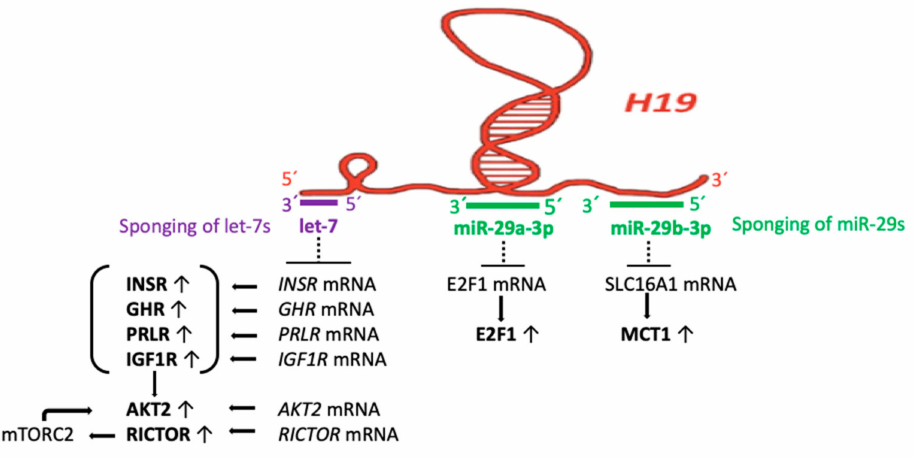
Figure 3. Long non-coding RNA H19 augments β cell proliferation. H19 functions as a sponge of let-7 miRs and miR-29 family members, resulting in the enhanced expression of growth hormone receptors, AKT2, and the mTORC2 component RICTOR. Growth hormone receptors and mTORC2 activate AKT2 and its downstream target mTORC1. H19-mediated sequestration of miR-29a-3p enhances the expression of E2F1, a known transcription factor promoting H19 expression. H19-mediated- sponging of miR-29b-3p enhances the expression of monocarboxylic acid transporter 1 (MCT1 encoded on SLC16A1 ), a disallowed gene of mature β cells. Abbreviations: INSR = insulin receptor; GHR = growth hormone receptor; PRLR = prolactin receptor; IGF1R = insulin-like growth factor 1 receptor; AKT2 = AKT serine/threonine kinase 2; RICTOR = rapamycin-insensitive companion of mTOR; E2F1 = E2F transcription factor